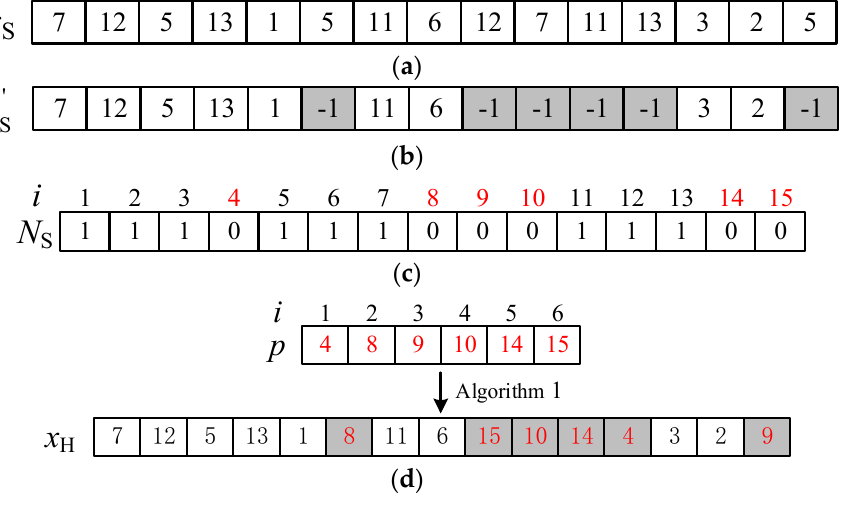
Figure 4. Handling repeated values in sequence x (cid:48) Table 1. Pseudo-code for Algorithm 1. Algorithm 1: Fill missing index values into sequence x (cid:48)